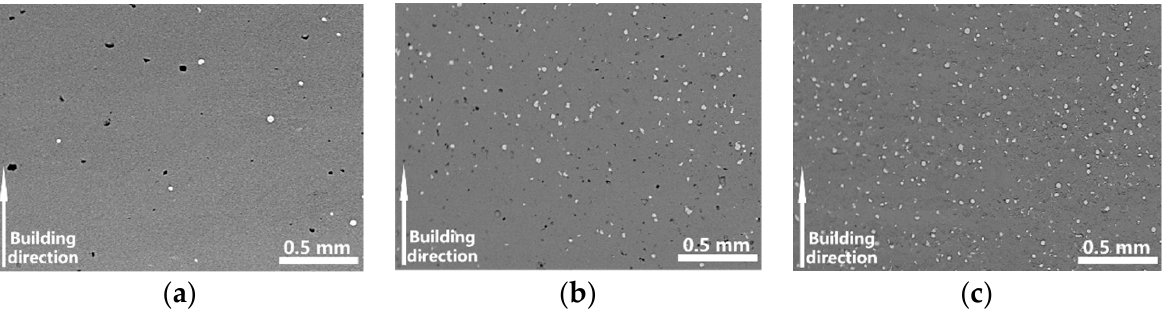
Figure 5. Optical micrograph of unmelted Ta particles in the etched LPBF-built Ti-Ta samples. ( a ) S1 ( v = 120 mm/s, E = 694 J/mm 3 ), ( b ) S2 ( v = 220 mm/s, E = 381 J/mm 3 ) and ( c ) S3 ( v = 1100 mm/s, E = 76 J/mm 3 ).